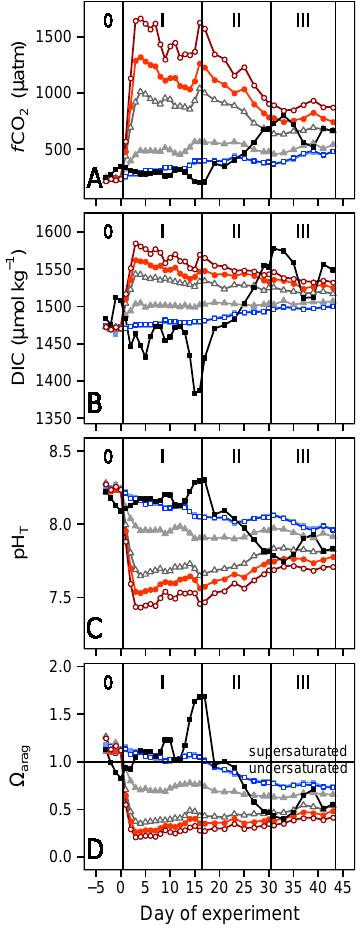
Figure 7. Dynamics in carbonate chemistry speciation with (a) cal- culated fugacity of CO 2 , (b) measured dissolved inorganic car- bon concentrations, (c) measured pH on total scale and calculated for in situ temperatures, and (d) calculated saturation state ( (cid:127) ) of calcium carbonate (aragonite). (cid:127) arag and f CO 2 were calculated from DIC and TA using the stoichiometric equilibrium constants for carbonic acid of Mehrbach et al. (1973) as refitted by Lueker et al. (2000). Colours and symbols are described in Table